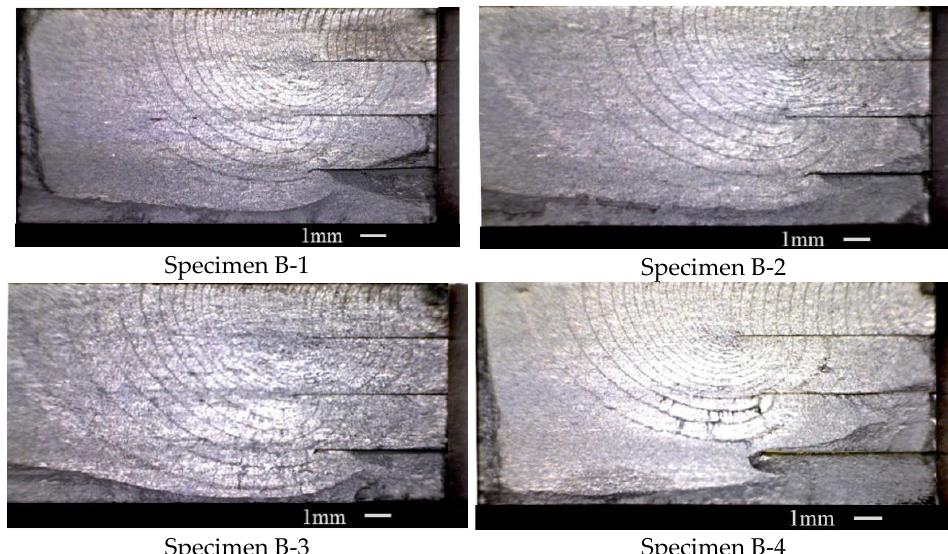
Figure 7. The four specimens’ fracture surfaces of Group B.